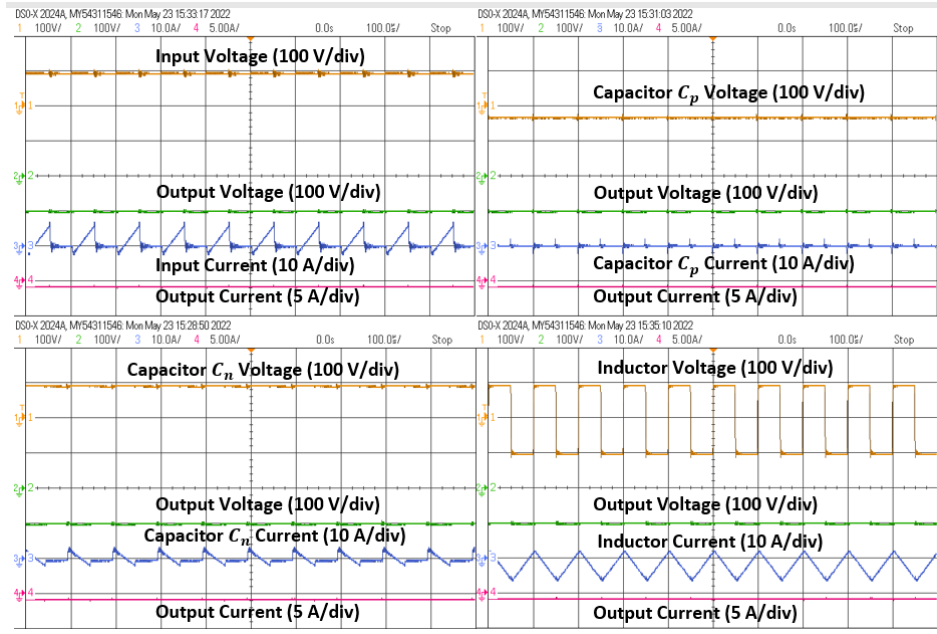
Figure 8. Steady-state response of mode 2 at d = 0.5.